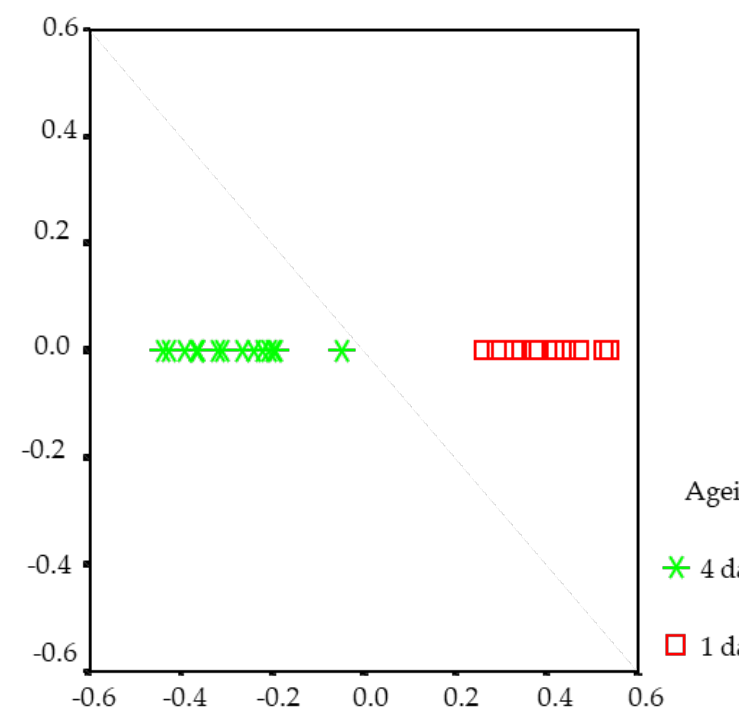
Figure 4. Separation of “days of ageing” groups obtained applying the discriminant analysis to odour and flavour attributes and volatile compounds of the Longissimus thoracis muscle from Navarra breed lambs.